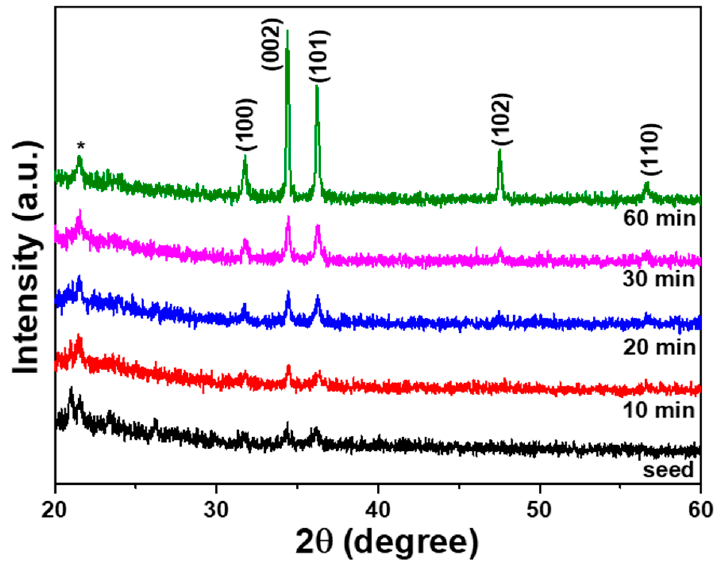
Figure 7. XRD spectra of the ZnO seed layer and ZnO nanoflower arrays on the SC-B substrate as a function of synthesis time; *—AB glue.